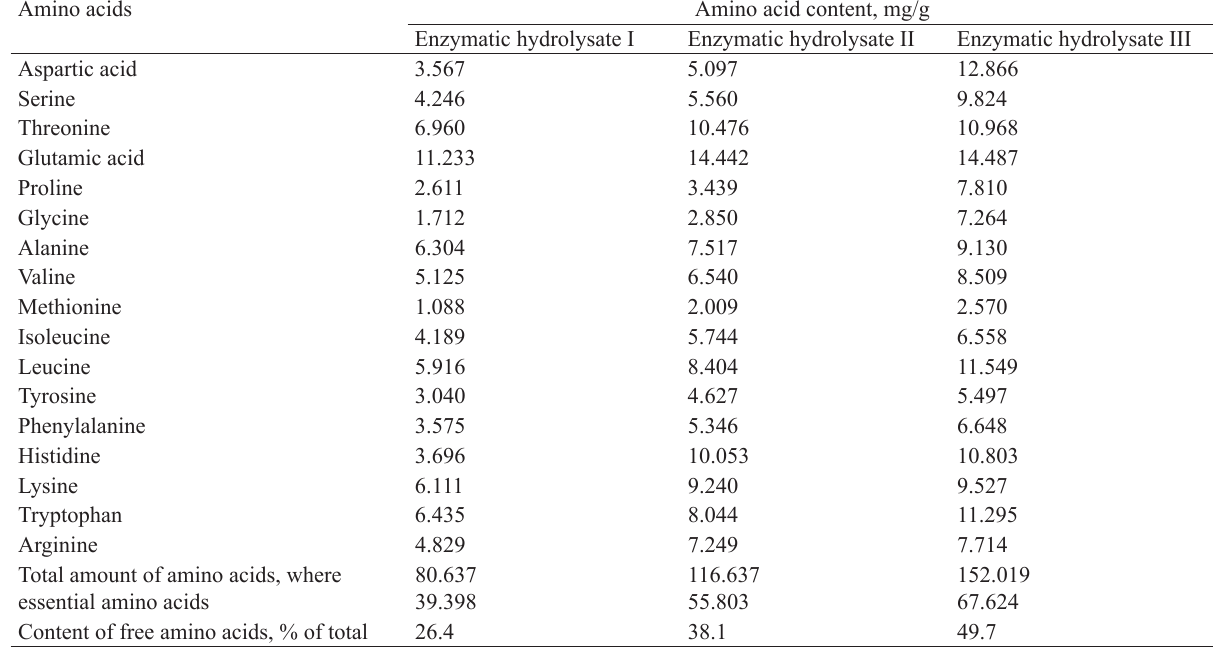
Table 3 Composition of free amino acids in enzymatic hydrolysates of the microbial biomass mix ( Aspergillus oryzae and Sаcharomyces cerevisiae )